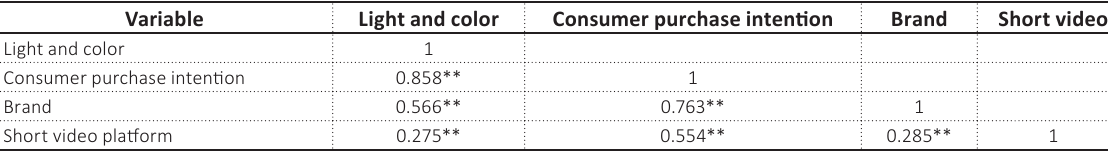
Table 2. Mean, variance and Pearson correlation coefficient of main variables